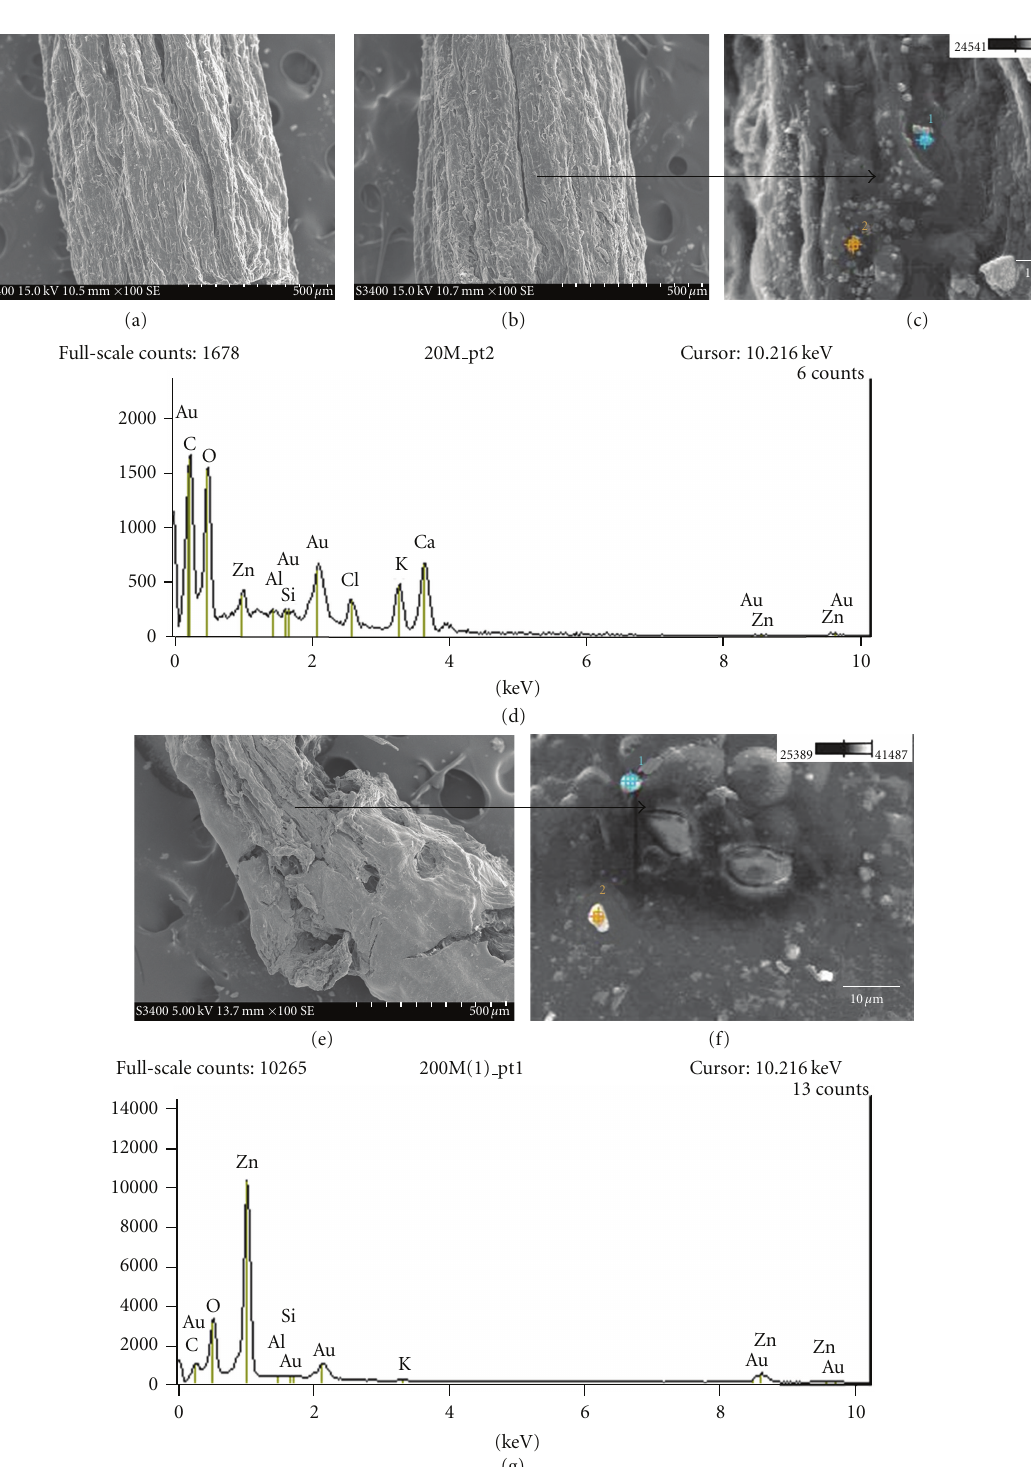
Figure 6: Scanning electron micrographs of roots of mung (Vigna radiata) (a) control, (b) at 20 ppm with EDAX (c) and (d) and (e) at 2000 ppm with EDAX (f) and (g) of nano-ZnO treatment. The energy dispersive spectroscopy shows the Zn peaks obtained from points indicated by the